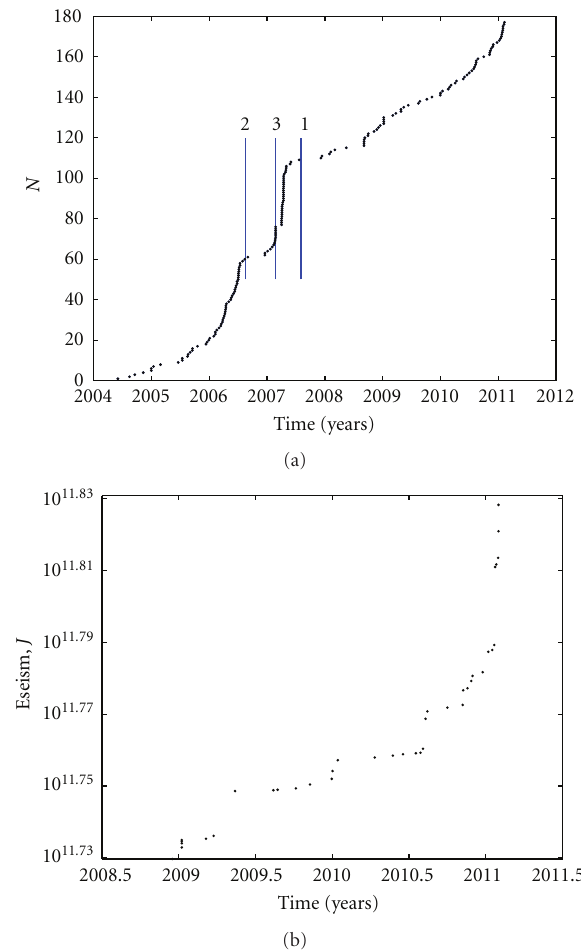
Figure 10: Cumulative graphs of a number of the events (a) and of released seismic energy (b) inside the area 48 ◦ -49 ◦ N and 141.5 ◦ – 143 ◦ E. Vertical lines and figures show the moments of the Nevelsk (1), Gornozavodsk (2) earthquakes, and the strongest earthquake of February 24, 2007, M = 4 . 6 (3) occurred in the pointed